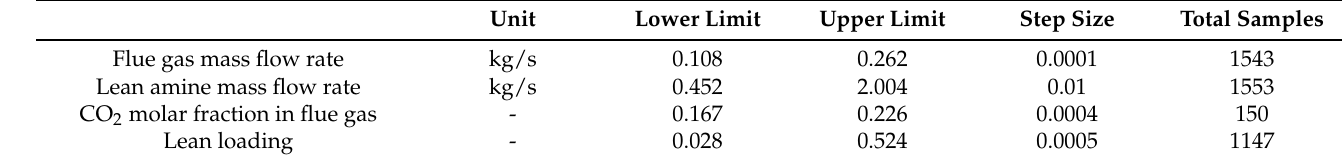
Table 4. Data collection information.